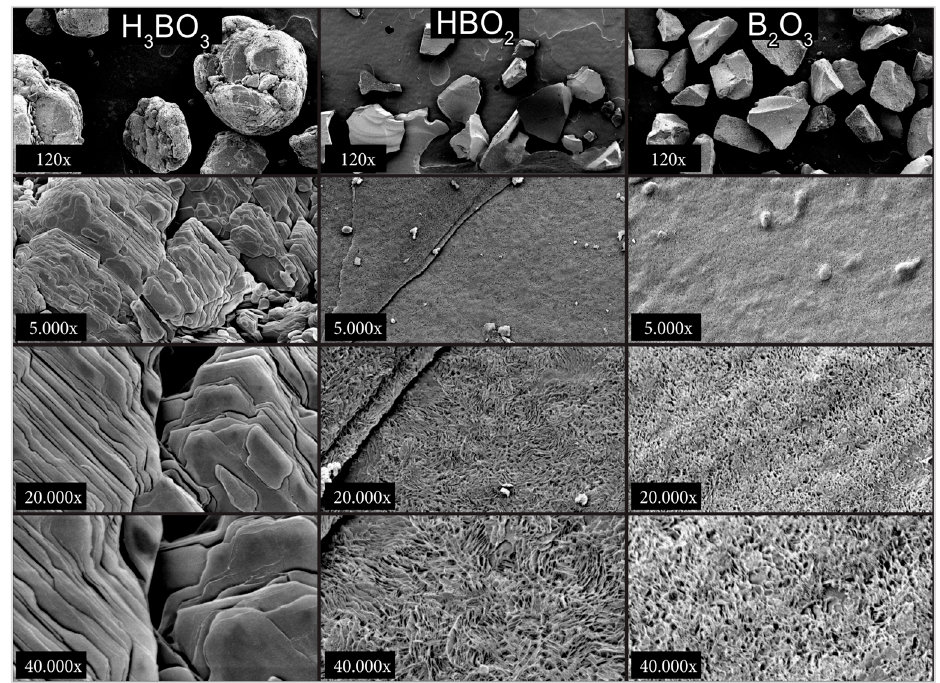
Figure 4. SEM images of H 3 BO 3 (first column), HBO 2 (second column) and B 2 O 3 (third column) at different resolutions (lines) of 120×, 5000×, 20,000×, and 40,000× (accelerating voltage: 2.5 kV).